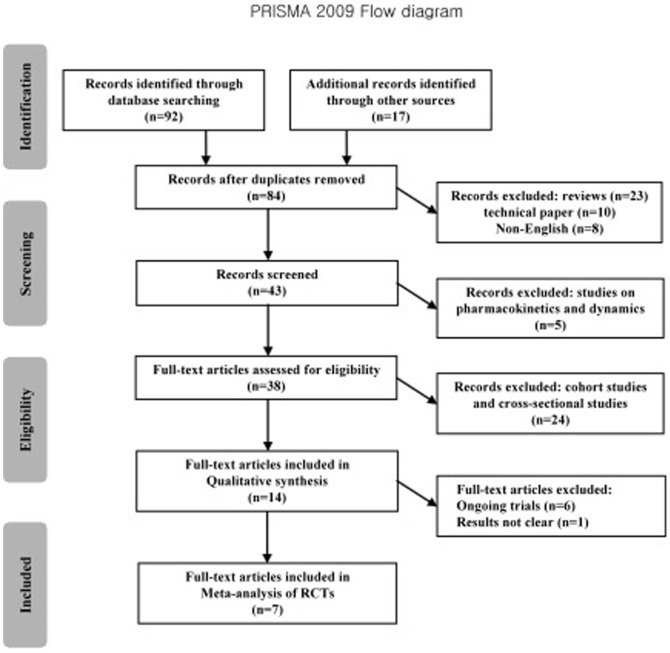
Literature search flow chart.